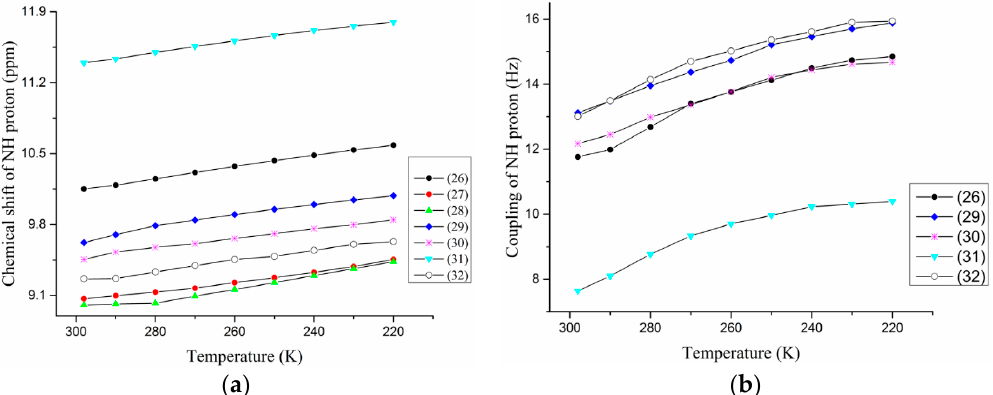
Figure 26. Variation of ( a ) chemical shifts of NH protons as a function of temperature for the molecules 26 – 32 and ( b ) through space mediated HF coupling constant as a function of temperature for the molecules 26 and 29 – 32 . The molecules are identified by the symbols given in the inset. The initial concentration was 10 mM in CDCl 3 .